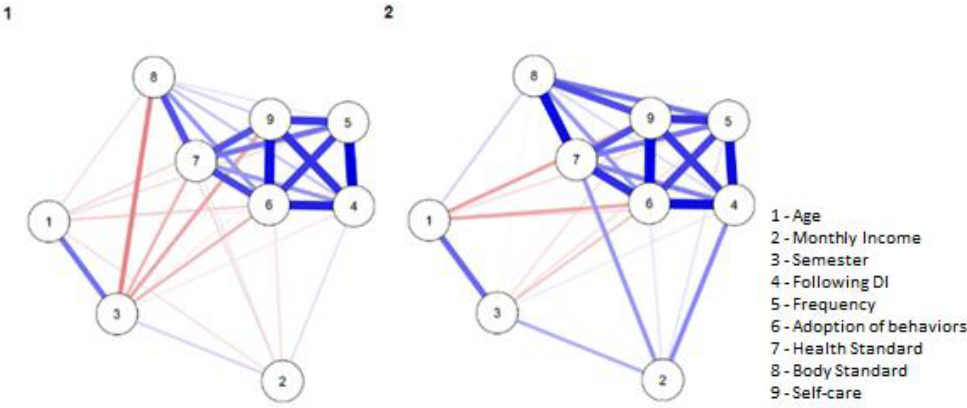
Figure 1. Network analysis of the associations between Instagram use profile as a means for the adoption of behaviors related to health, age group, monthly income, and semester for men (1) and women (2). Legend: Following DI — following digital influencer; Frequency — frequency of access to Instagram; Adoption of behaviors — whether the individual adheres to the behaviors suggested by the digital influencer; Health Standard.